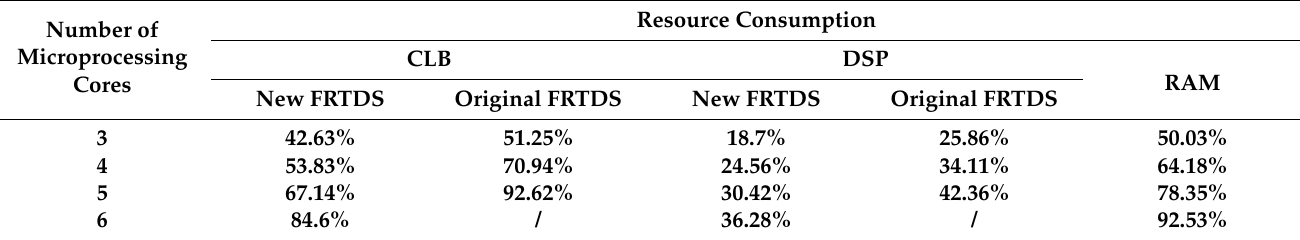
Table 1. Resource consumption of the improved FRTDS